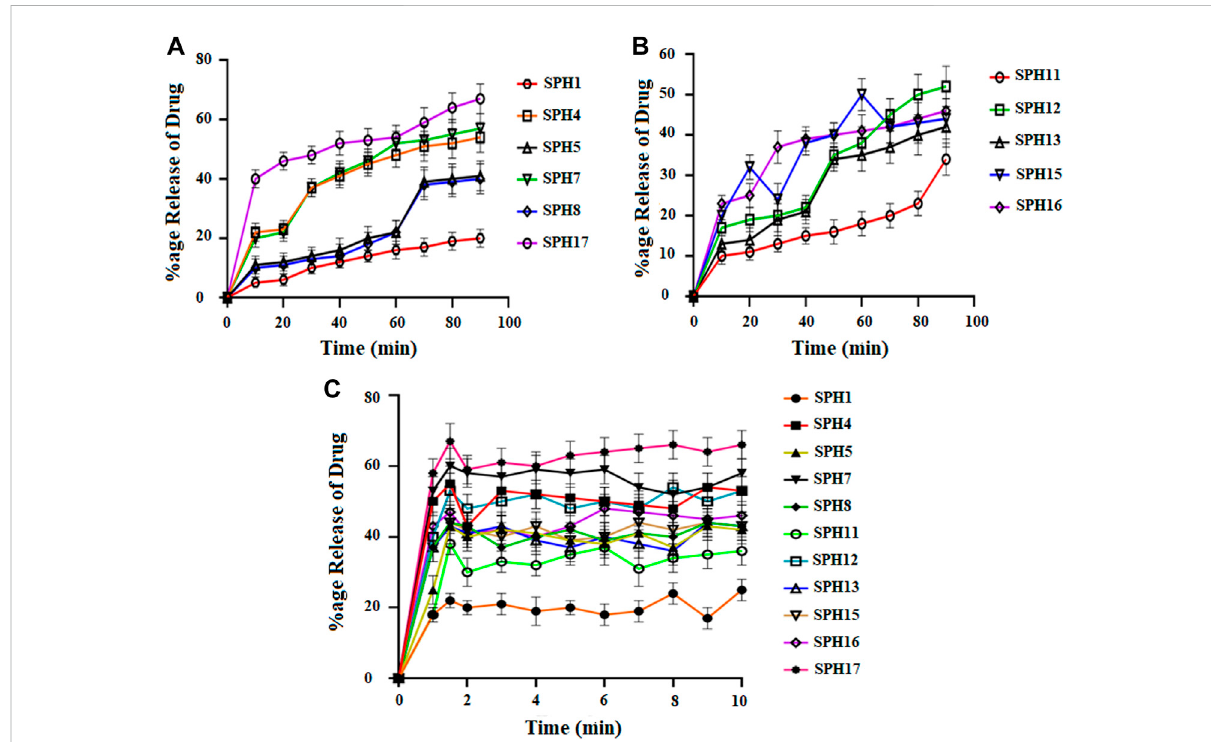
FIGURE 5 Cumulative Percent release of Mefenamic acid from the Superporous Hydrogels formulations (SPH 1, SPH 4, SPH 5, SPH 7, SPH 8, and SPH 17) (A) (SPH 11, SPH 12, SPH 13, SPH 15, SPH 16) (B) , in O.1 NHCL and (SPH 1, SPH 4, SPH 5, SPH 7, SPH 8, SPH 11 – 13, and SPH 15 – 17) (C) in phosphate- buffer-pH 6.8 ( n =